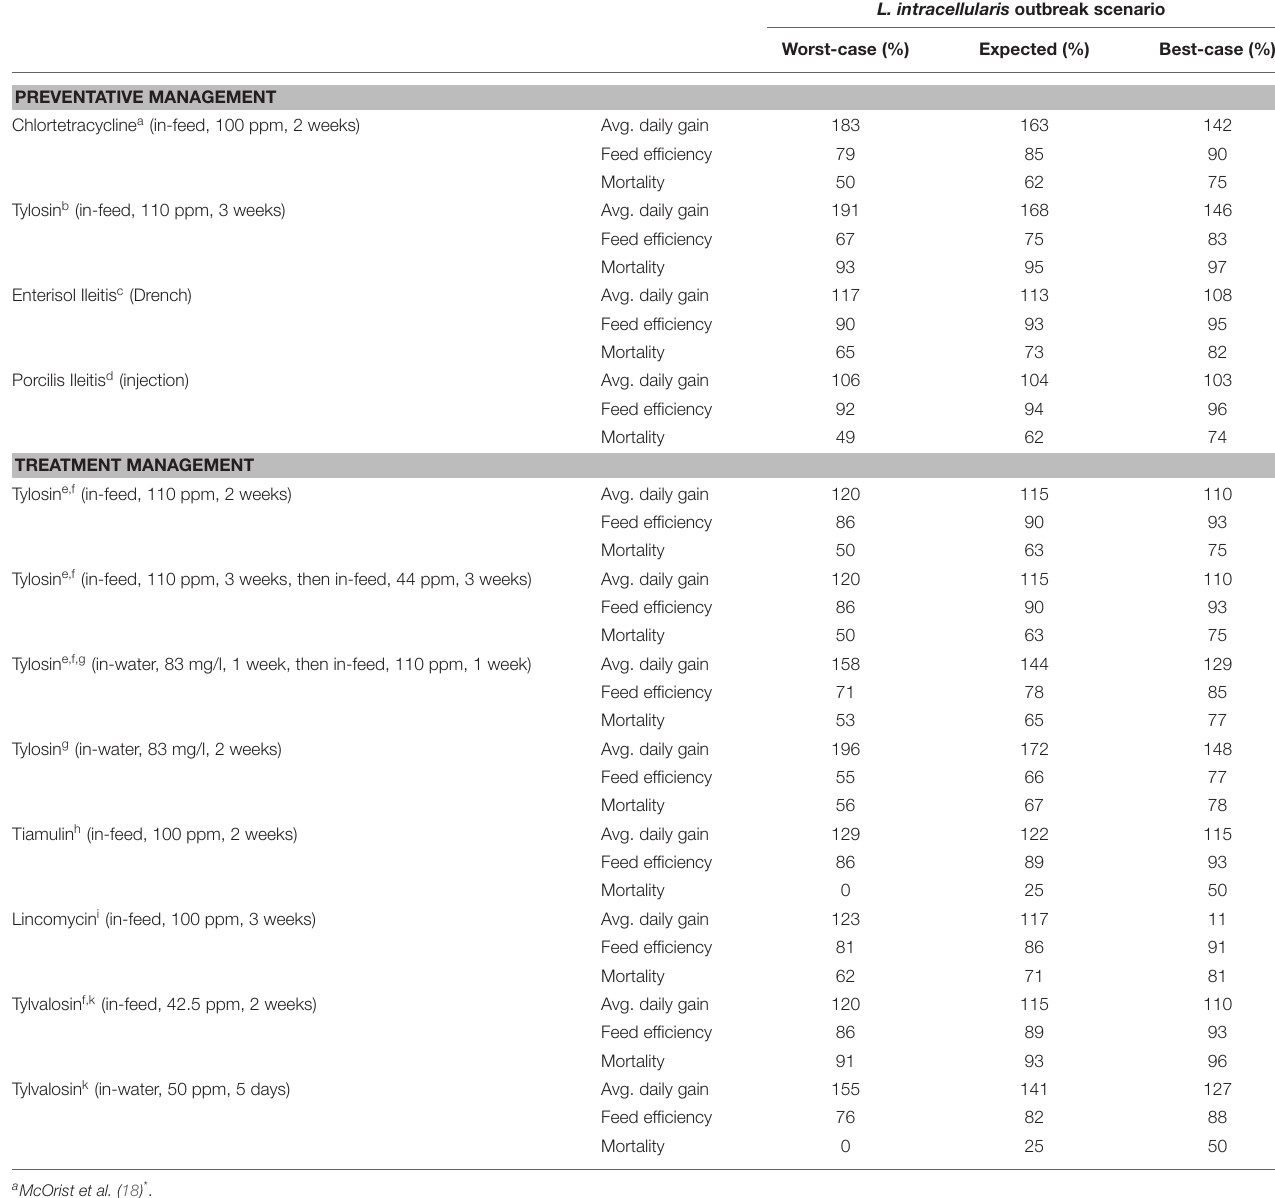
TABLE 5 | Change in production parameters from management options for L. intracellularis